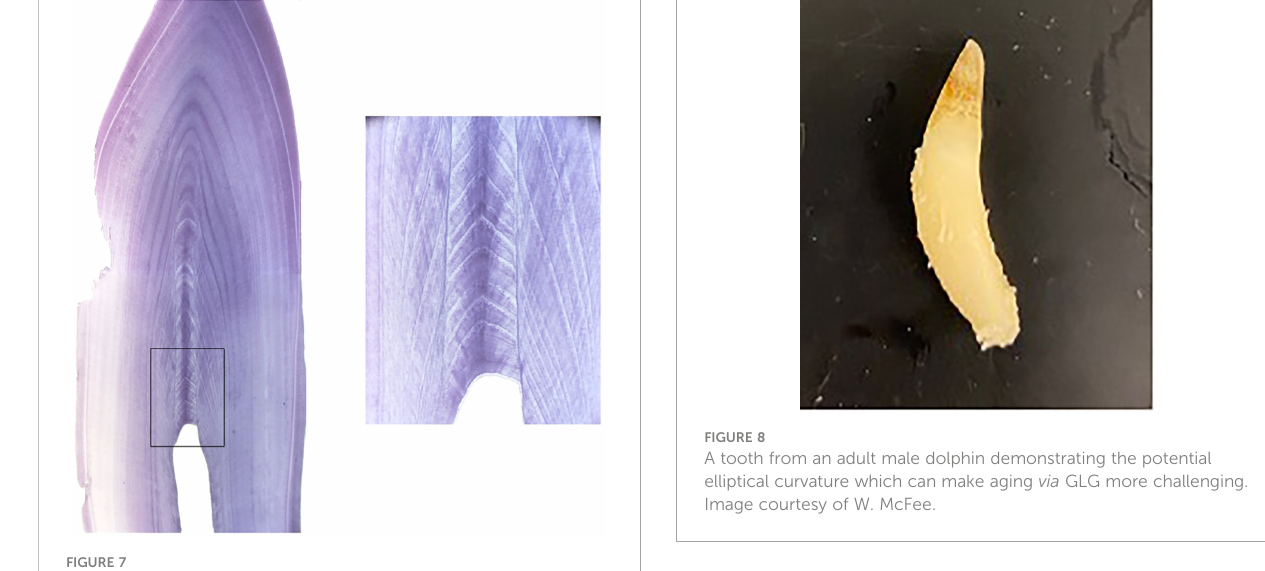
FIGURE 7 Tooth cross section highlighting the area where the GLG counts are produced and the level of detail and perfect cross-section required to view the newest layers. Image courtesy of A.